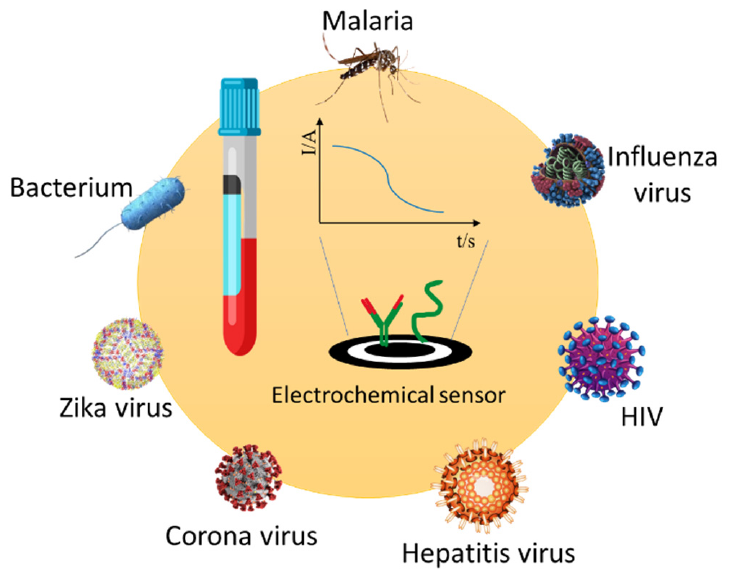
Figure 3. Schematic representation of the electrochemical sensor for the diagnosis of viral and tropical diseases.